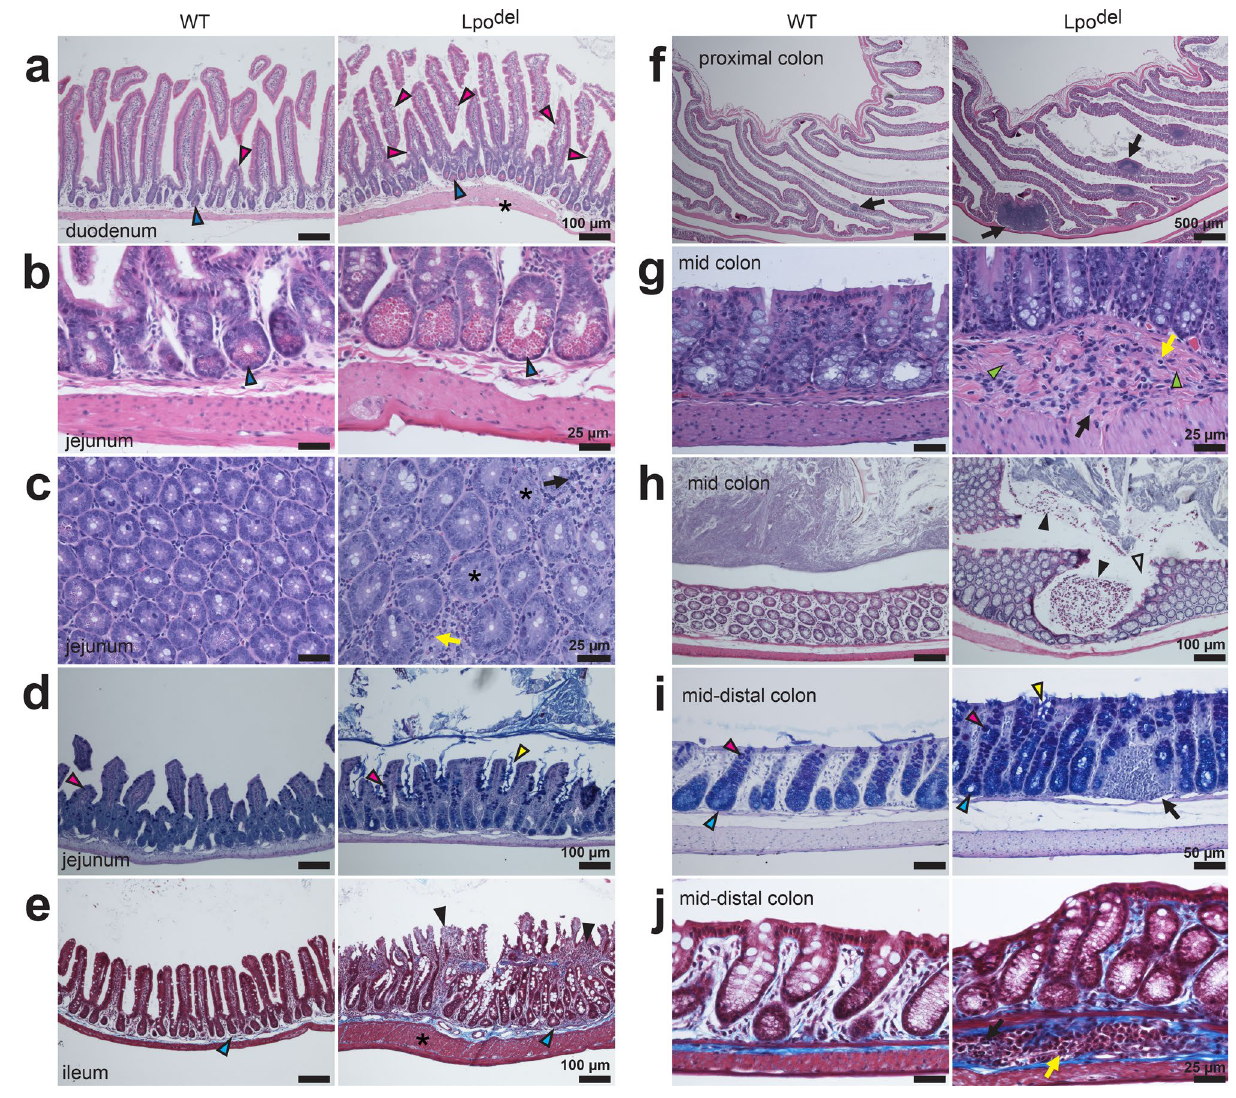
Figure 5. Histopathology in the small intestines and colon of Lpo del mice. ( a – e ) Longitudinal sections of indicated regions of wild-type (left) or mutant (right) small intestines, stained by HE unless specified. ( a ) Sections showing Paneth cells containing eosinophilic granules (blue arrowheads) or goblet cells containing unstained mucin granules (magenta arrowheads). The mutant sample displayed hyperplastic Paneth and goblet cells plus thickened muscularis (asterisk). ( b , c ) The mutant samples exhibited hypertrophic Paneth cells (blue arrowheads, b ), or infiltration of mononuclear (black arrow) and polymorphonuclear leukocytes (yellow arrow, c ) between villi (asterisks). Sections in panel ( c ) were perpendicular to villi. ( d ) ABPASH stains revealing increased mucin (blue or red, together giving purple) in the goblet cells (magenta arrowheads) or secreted mucin (yellow arrowhead) between villi in the mutant sample. ( e ) MT stain revealing collagen deposition (blue). The mutant sample displayed hypercellular (black arrowheads) and hyperplastic (cyan arrowhead) villi, and thickened muscularis (asterisk). ( f – j ) Longitudinal sections of indicated regions of the wild-type (left) or mutant (right) colon, stained by HE unless specified. ( f ) Sections exhibiting one small GALT (arrow) in the submucosa of the wild-type sample and multiple larger leukocyte clusters (arrows) in the mutant sample. ( g , h ) Sections where the mutant sample exhibited, in the mucosa or submucosa, mononuclear (black arrow, g ) and polymorphonuclear leukocytes (yellow arrow, g ), apparent fibrosis (lime arrowheads, g ), erosion of mucosa (open arrowhead, h ), and cellular sloughing (closed arrowheads, h ). ( i ) ABPASH-stained sections where the mutant sample exhibited hyperplastic goblet cells (magenta arrowheads) and crypt units (cyan arrowheads), excessive secreted mucin (yellow arrowhead), and leukocyte infiltrates (black arrow) in the mucosa. ( j ) MT-stained sections revealing collagen deposition (blue), with mononuclear (black arrow) and polymorphonuclear leukocytes (yellow arrow) in the submucosa of mutant sample. Scale bars are 25 µm ( b , c , g , j ); 50 µm ( i ); 100 µm ( a , d , e , h ); 500 µm ( f